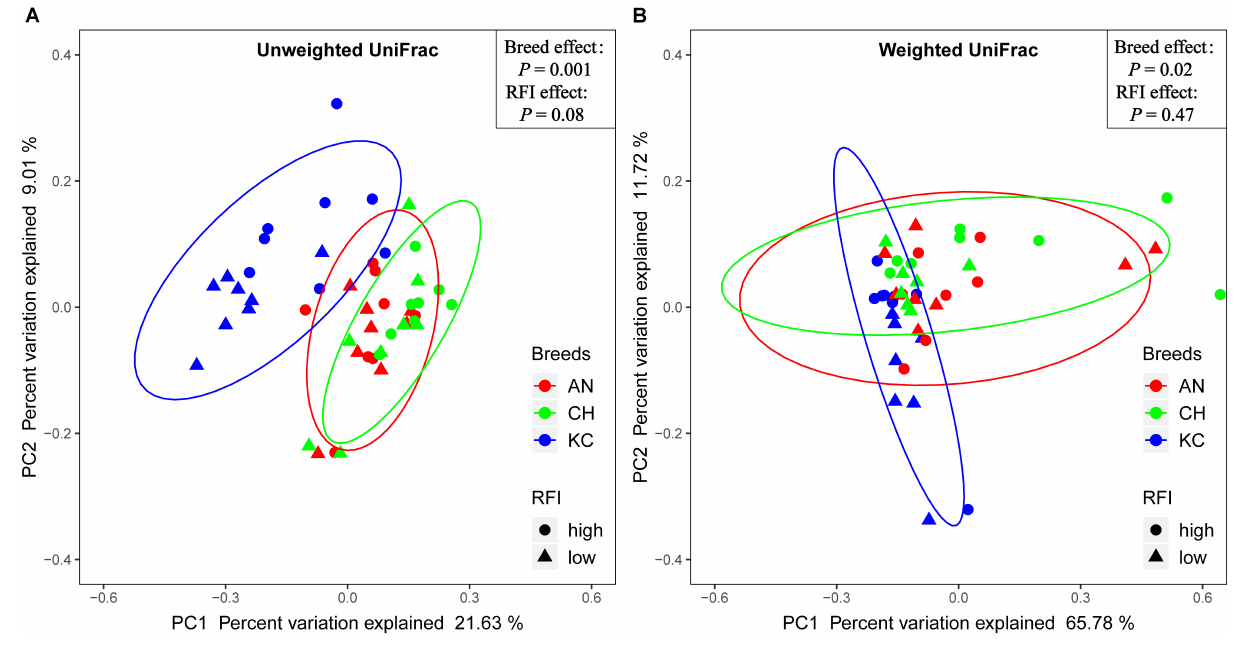
FIGURE 4 | Similarity of the rumen eukaryotic profiles between beef cattle with divergent residual feed intake (RFI) from three breeds. Distance between samples based on similarity in representative sequence variants (RSVs) composition was calculated using unweighted UniFrac (A) and weighted UniFrac distance (B) and visualized using principal coordinate analysis (PCoA) plots. The impact of breed and RFI on the clustering pattern of microbial communities was tested using PERMANOVA. The AN, CH, and KC represent Angus, Charolais, and Kinsella Composite beef steers, respectively. The ovals in blue, red, and green represent 95% confidence interval of KC, AN, and CH,